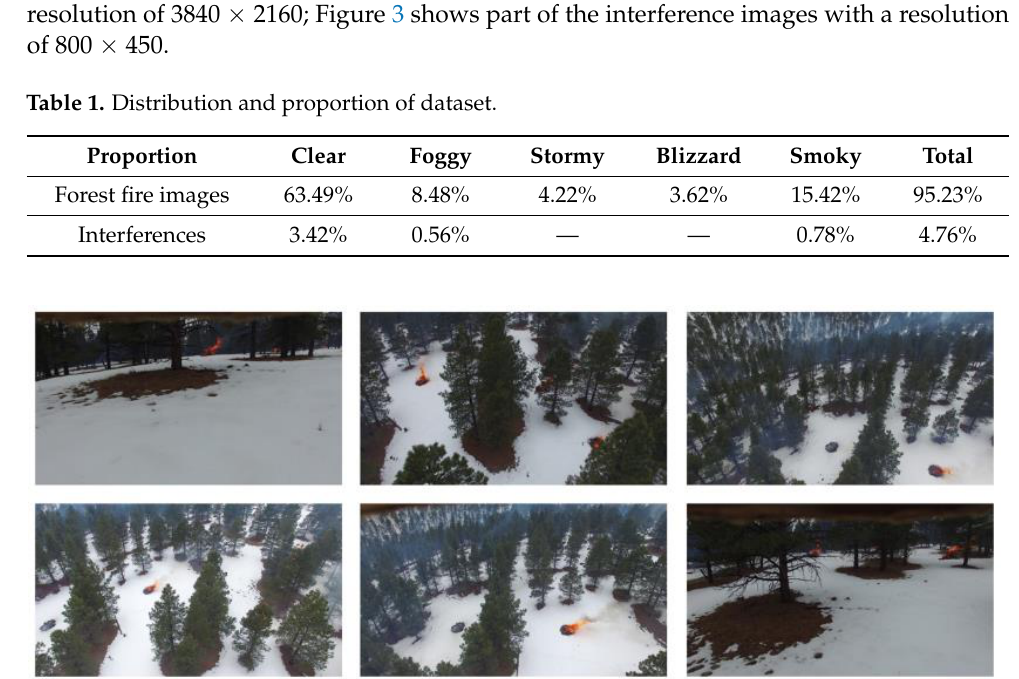
Figure 2. Part of the forest fire images.